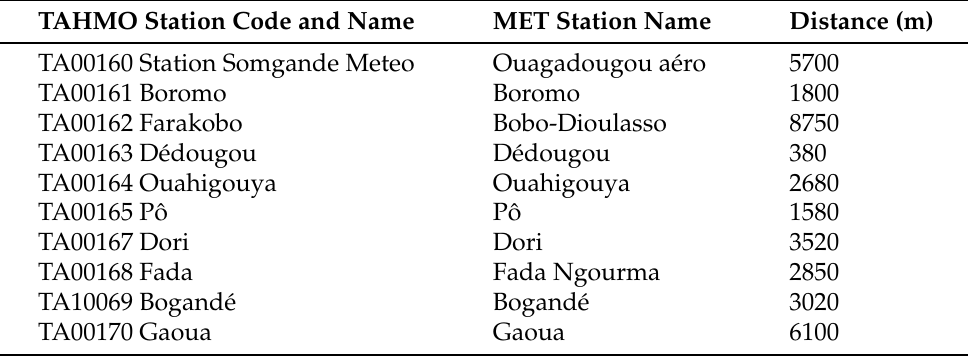
Table 1. TAHMO station code and name, the corresponding meteorological station name and the distance between those two stations is listed. These 10 TAHMO stations are compared to 10 meteorological reference stations (MET